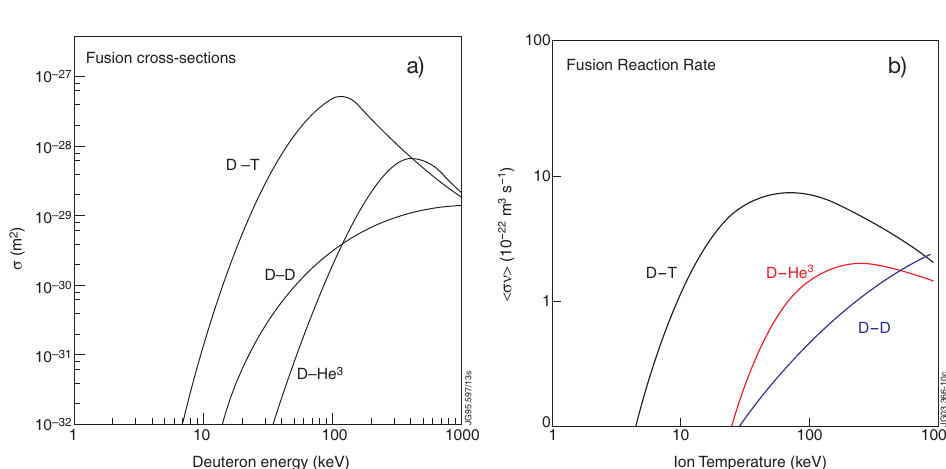
Fig. 1. – Fusion cross sections and fusion reactivity for the three main fusion reactions. The cross section is plotted as a function of the energy of the deuteron impinging on the target at